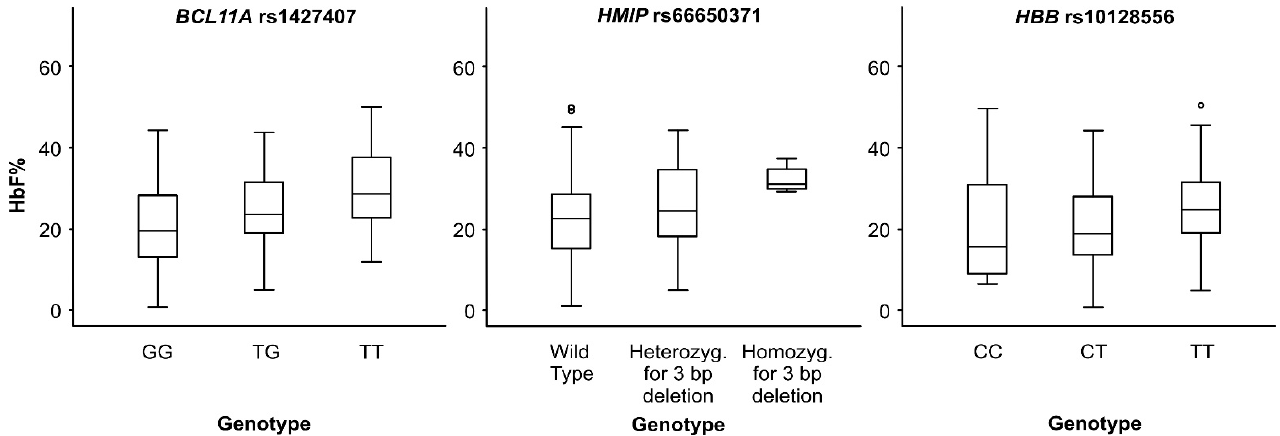
Figure 1. Box plots showing the relationship between HbF levels and the genotypes of rs1427407, rs66650371 and rs10128556. The values within the box range from 25th to 75th percentiles. The horizontal line within the box corresponds to the median value.